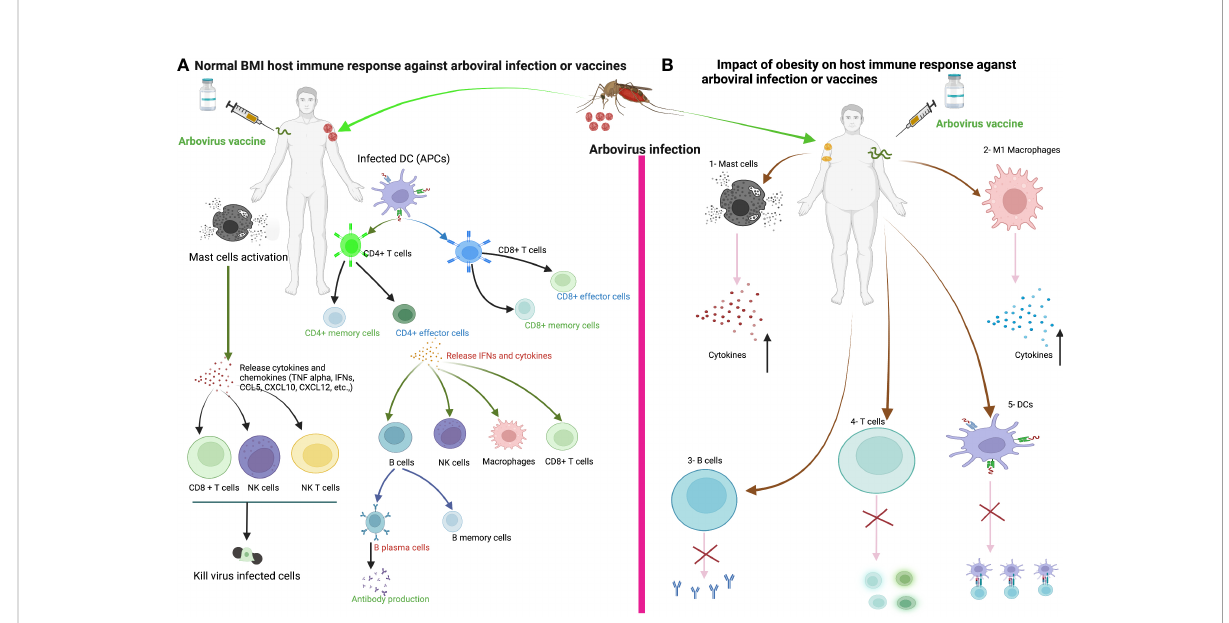
FIGURE 3 The immune response of healthy weight and obese individuals to arbovirus infection or vaccination. (A) The immune response of healthy individuals to arbovirus infection or vaccine. Sentinel cells of the immune system, such as dendritic cells, mast cells and macrophages, encounter the virus after infection from a mosquito bite or vaccine injection. Mast cells degranulate within minutes of recognizing the virus and release various cytokines/ chemokines that activate other immune cells such as CD8+ T, natural killer (NK), NKT cells and macrophages against the viral infection to promote viral clearance. Dendritic cells or macrophages become infected and present viral antigens to CD4+ and CD8+ T cells to initiate an adaptive immune response. (B) We can speculate that the development of obesity disrupts the innate and adaptive immune cells during arboviral infection or vaccination, ultimately affecting the course of arboviral disease and the induction of the host immune response to the vaccine. 1-Increased production of proin fl ammatory cytokines from Mast cells in obesity. 2- Increase proin fl ammatory cytokines production from M1 macrophages in obesity. 3-Delayed antibody production. 4-Impaired activation of naïve T cells and Delayed CD4+ and CD8+ T cells response in obesity. 5-Impaired antigen presentation by DC in